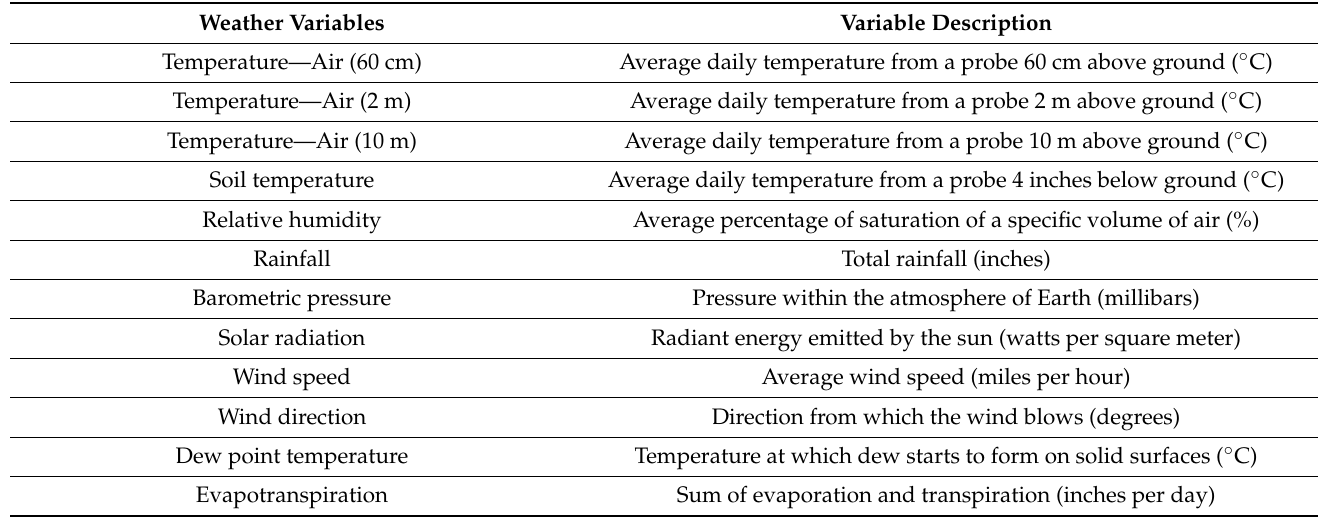
Table 1. Weather Variables.